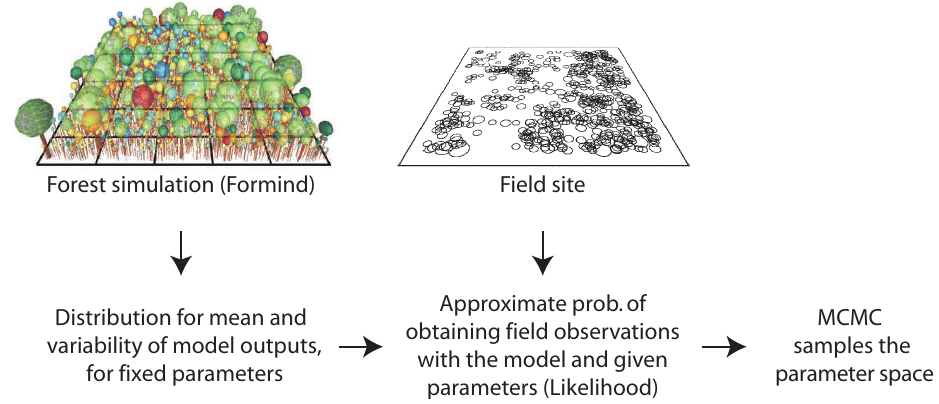
Fig. 2. Illustration of the estimation process: at the top left, a visualization representing the FORMIND model. Different colors represent different PFTs. The model is compared to the field data (middle) by fitting a distribution to the stochastic model output, and calculating the approximate probability of observing the field data from this distribution. This approximate likelihood value feeds into the conventional Bayesian